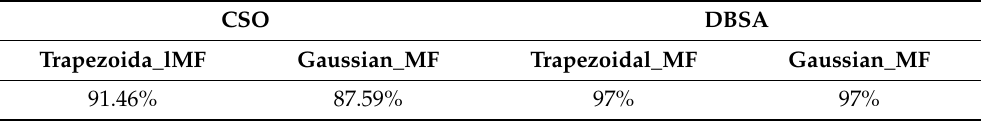
Table 10. Comparative of the different optimization results.